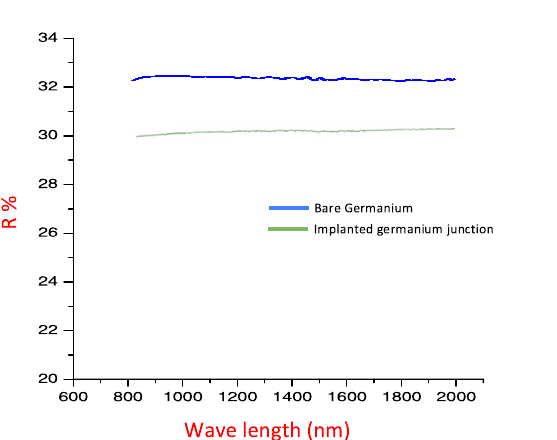
Fig. 2. Re fl ectivity of germanium junctions.